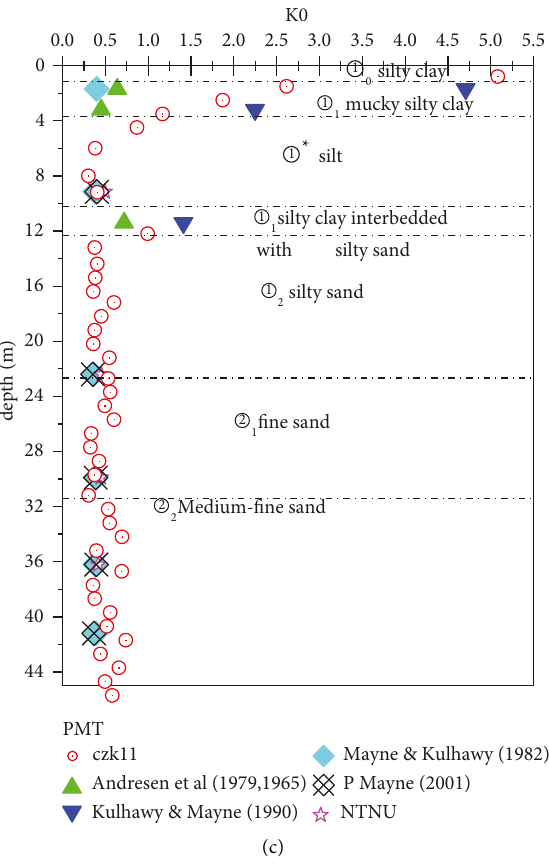
Figure 6: Estimated versus measured K